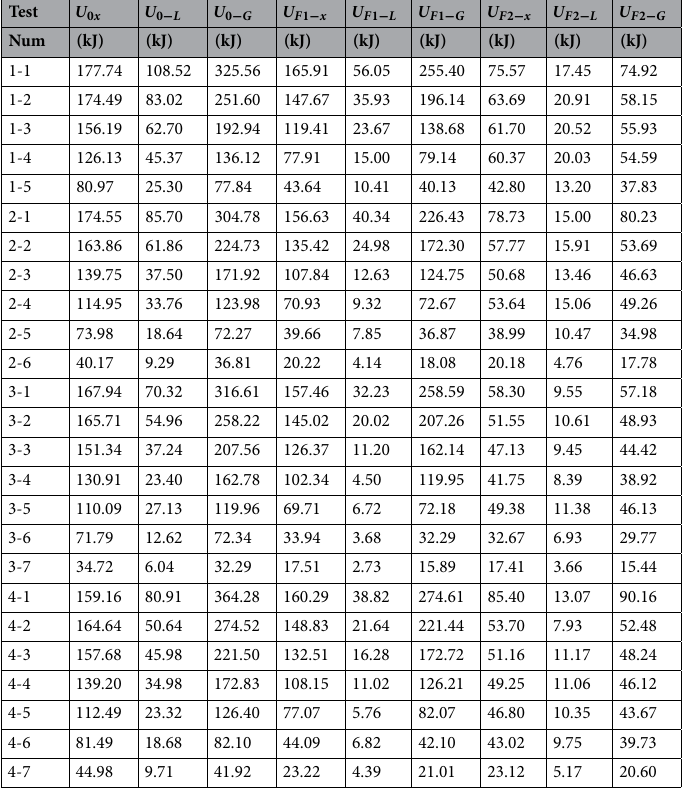
Table 9. The calculated internal energy U (kJ), solved with Eq. (4), utilizing the measured temperature in Table 4, and the densities tabulated in Table